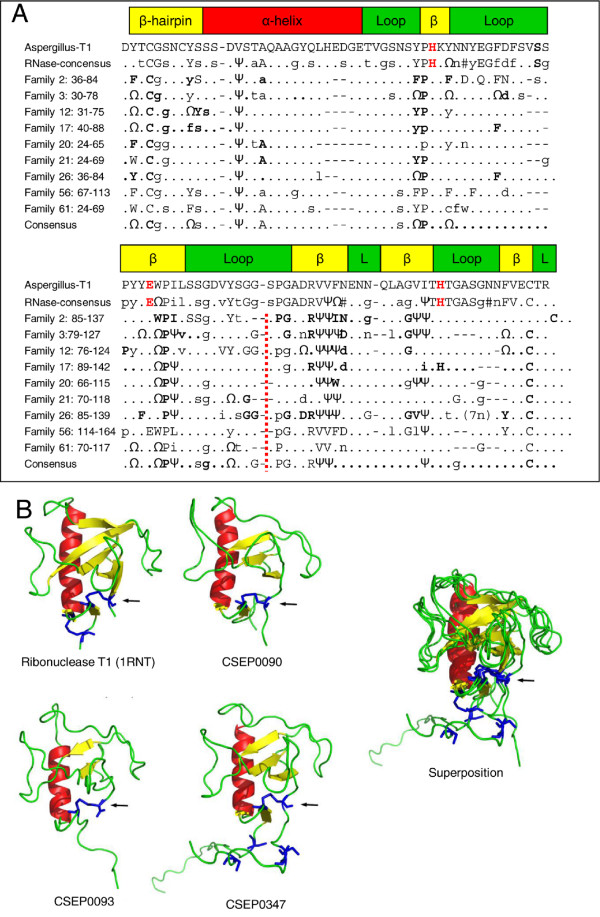
Multiple sequence alignment and 3D models of ribonucleases and CSEPs. A: Multiple sequence alignment of ribonuclease T1 from Aspergillus oryzae, a ribonuclease consensus sequence and selected CSEP family consensus sequences. The ribonuclease consensus was derived by aligning ribonucleases from Aspergillus phoenicis (P00653, Penicillium brevicompactum (P07446), Grosmannia clavigera (EFX05096), Phaeosphaeria nodorum (XP_001800520) and Mycosphaerella graminicola (EGP89360). The alignments were manually edited based on MultAlin-alignments (http://multalin.toulouse.inra.fr/multalin/multalin.html). The CSEP families included are primarily those showing most ribonucleases identified by InterProScan or by the structural annotation. The secondary structures (α-helix, β-sheets and loops) of ribonuclease T1 from Aspergillus shown on top are according to Pace et al.
[54]. Catalytic active site residues in ribonucleases are indicated in red. Intron position is indicated by a red vertical dashed line; there is one exception, one member of family 56 does not have this intron. Amino acid numberings are the ranges for each family. Upper case letters indicate highly conserved positions, while lower case letters indicate that the positions are present in some of the family members only. Omega (Ω) is used for aromatic amino acids (F, Y and W), and psi (Ψ) is used for V, L and I. Letters in bold indicate that the positions are under purifying selection. Dots indicate non-conserved positions and dashes are gaps. B: 3D models of ribonuclease T1 and three CSEPs and their superposition. Arrows indicate the predicted disulphide bonds between the N- and C-terminal cysteines.